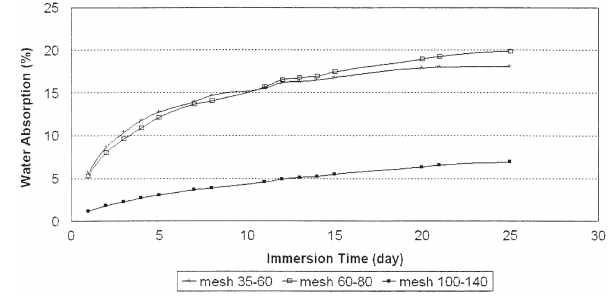
Figure 9: Variation of water absorption rate with immersion time